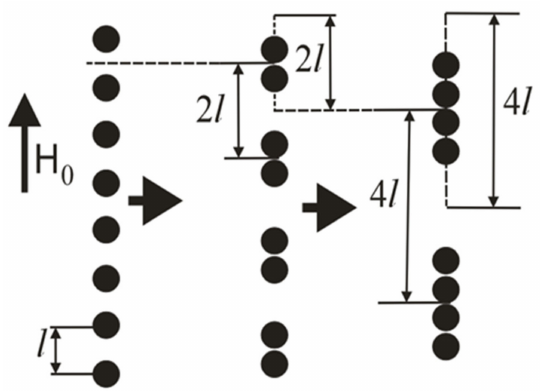
Figure 12. Sketch of three first stages ( k = 0, 1, 2) of the agglomerates aggregation. The horizontal arrows illustrate evolution of the agglomerates in time. The segments of possible positions of the chains are shown. The segment’s boundaries are for the poles of the agglomerates at the chains’ extremities. The single agglomerates and the chains are shown in the centers of the segments of their possible